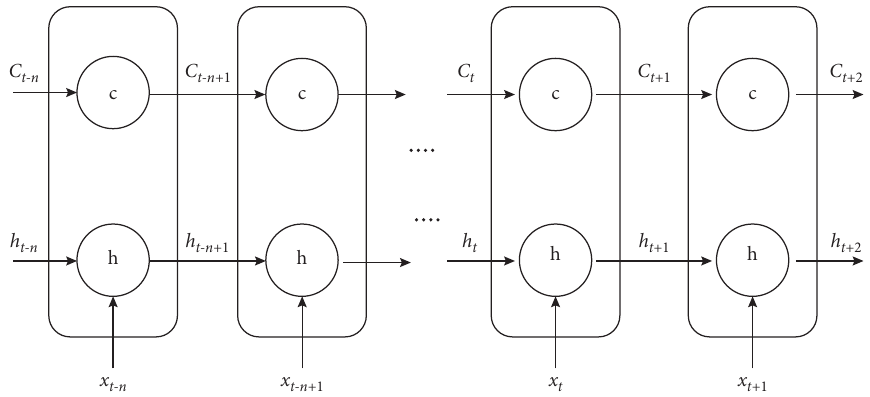
Figure 3: Recursive neural network timing